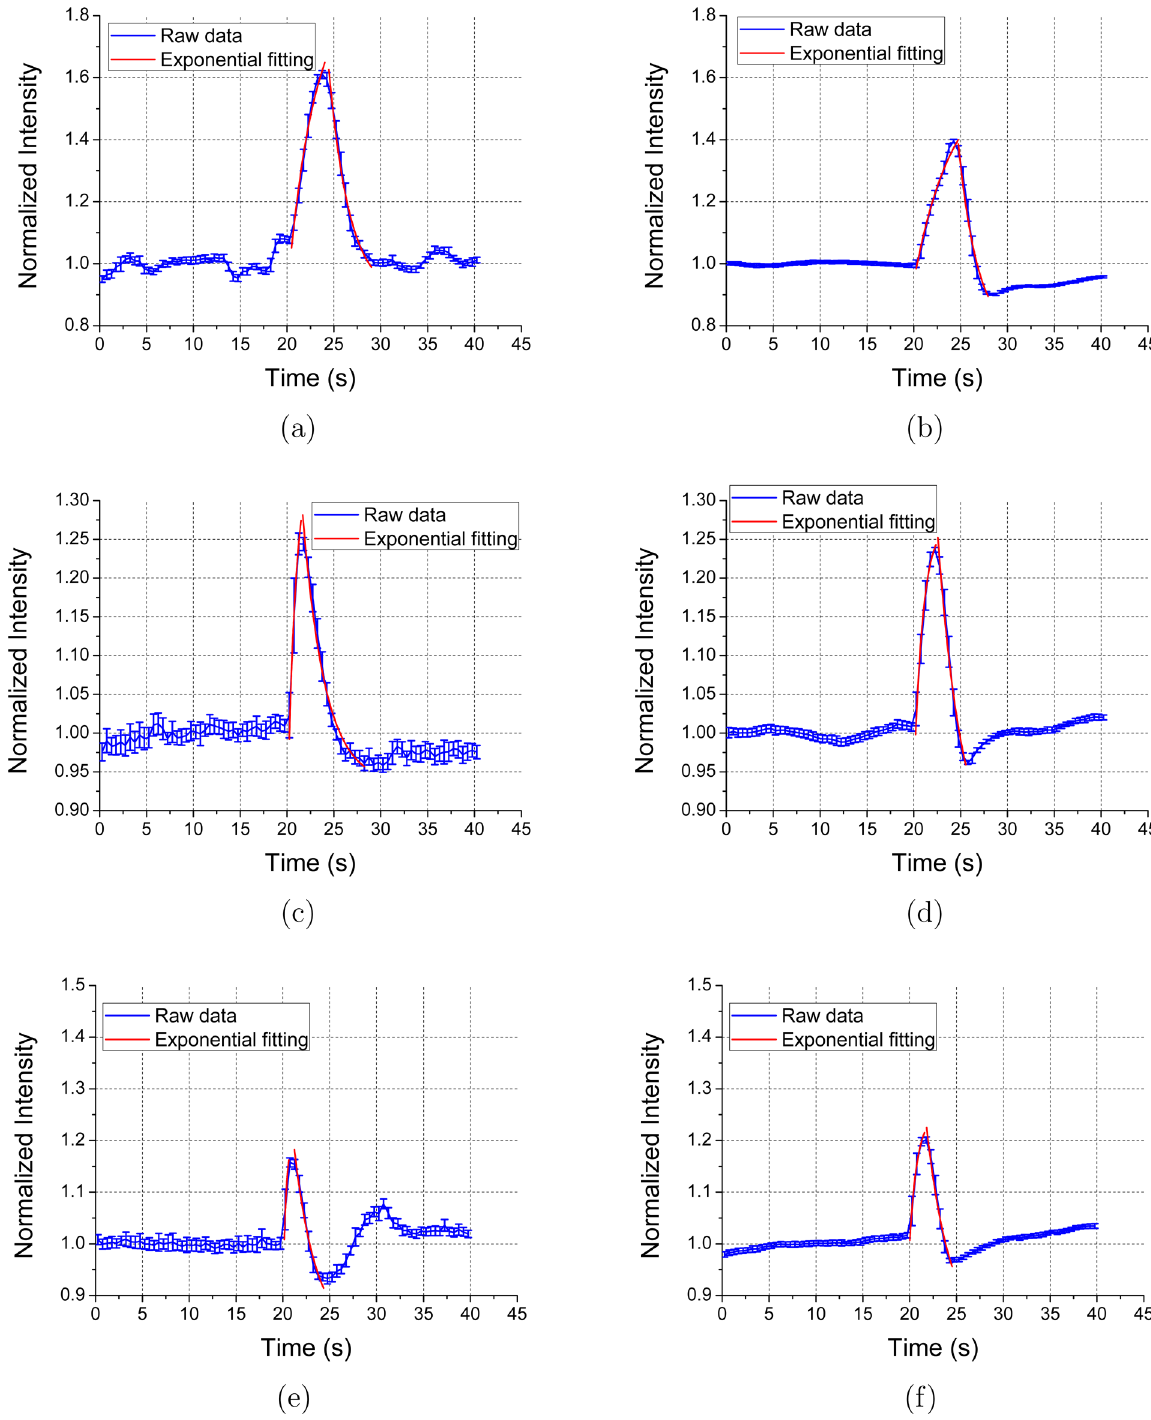
Fig 6. Fluorescence intensity induced by short duration US for (a) PyPC based liposomes at 430 kPa for 3.0 s; (b) PyPE based liposomes at 430 kPa for 3.0 s; (c) PyPC based liposomes at 570 kPa for 0.8 s; (d) PyPE based liposomes at 570 kPa for 0.8 s; (e) PyPC based liposomes at 850 kPa for 0.3 s; (f) PyPE based liposomes at 850 kPa for 0.3 s. The data were recorded with a sampling period of 10 ms. Three experiments were repeated with the sample replenished each time. The values from the three repeating experiments were firstly averaged and normalized by the intensity prior US sonication. The mean and standard deviation of 50 consecutive intensity values (corresponding to 500 ms measurement time) are shown. The small standard deviation (ratio of the standard deviation with the mean value is less than 4.2%) observed suggests good